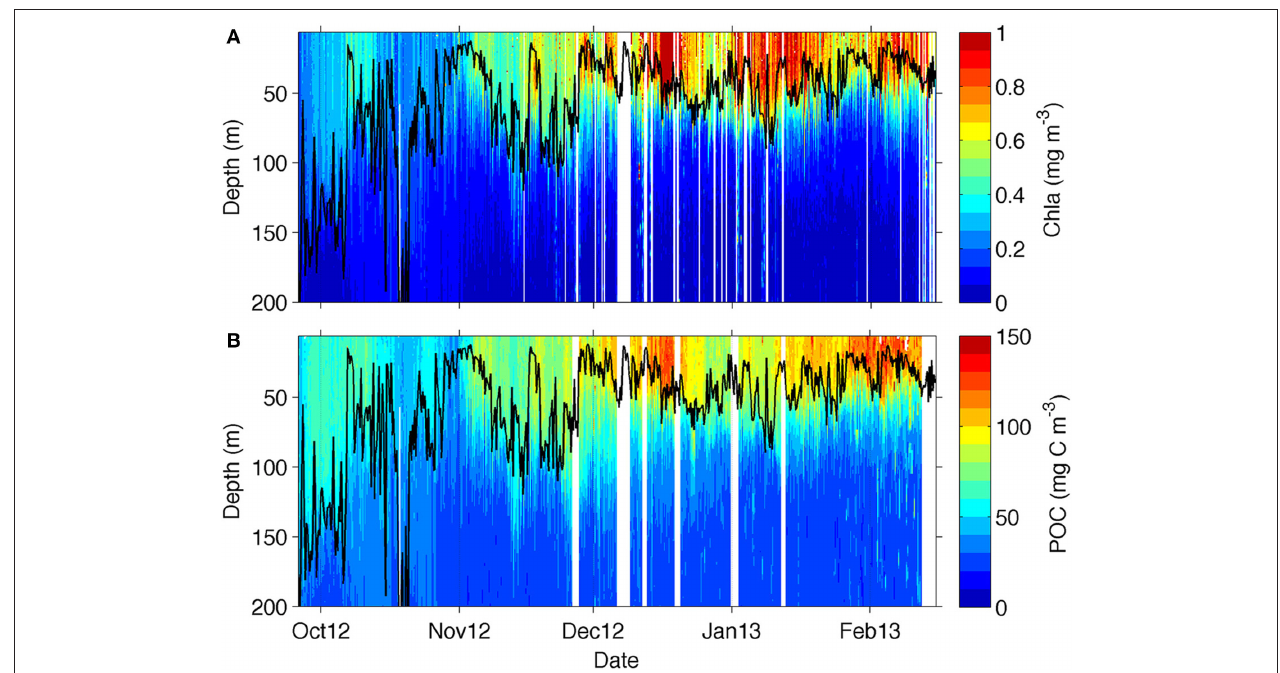
FIGURE 4 | Section plot from the glider transect data for (A) chlorophyll and (B) particulate organic carbon (POC) derived from backscattering data from equation (2). The mixed layer depth is marked as a solid black